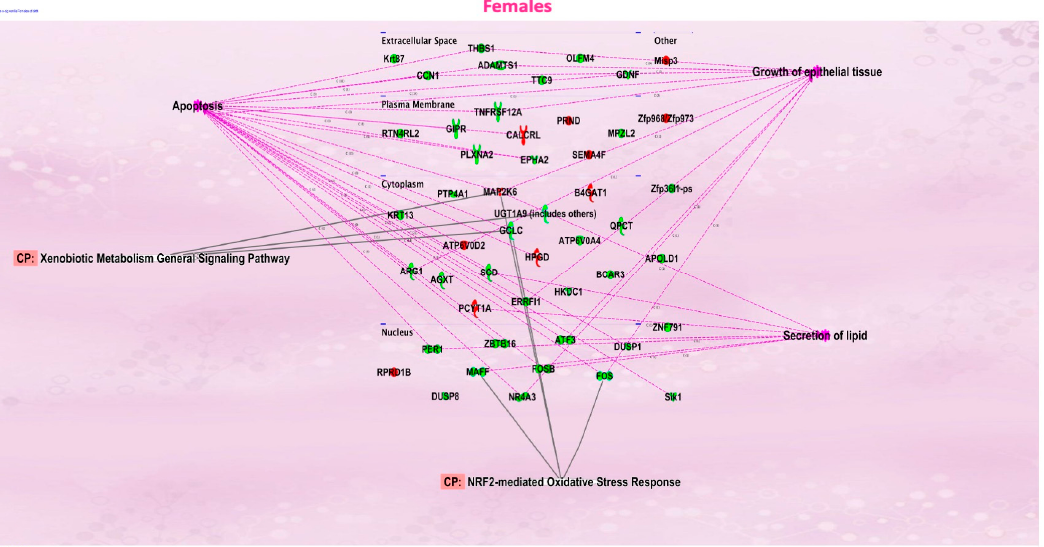
Figure 3. Ingenuity Pathway Analysis revealed that networks of inter-connected genes for protein- coding genes were associated with NRF2-mediated oxidative stress responses in the female offspring mice exposed in utero to vanilla-flavored e-cig aerosol and sacrificed at birth.